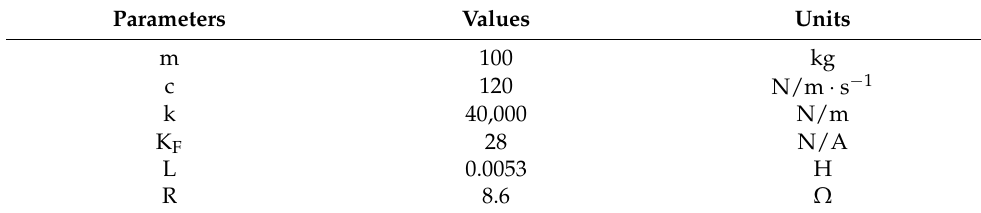
Table 1. Parameters table of Optomechanical coupling active control system.